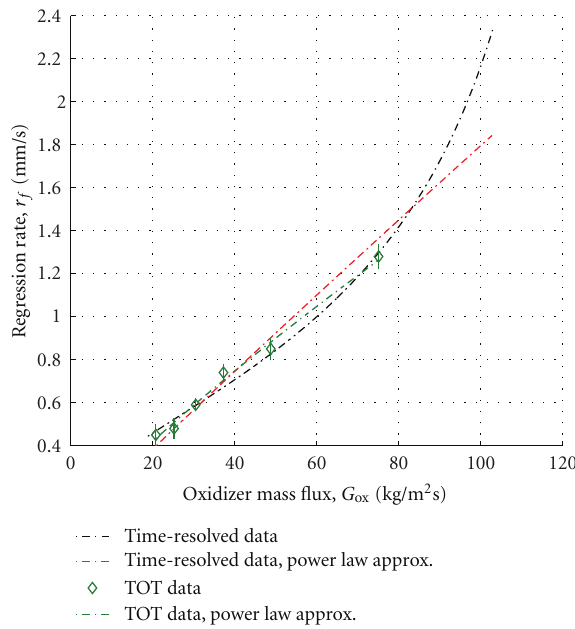
Figure 7: HTPB baseline, Test 3: example of experimental data r f ( G ox ) and TOT analysis results showing the di ff erent paths and concavities characterizing the two techniques.